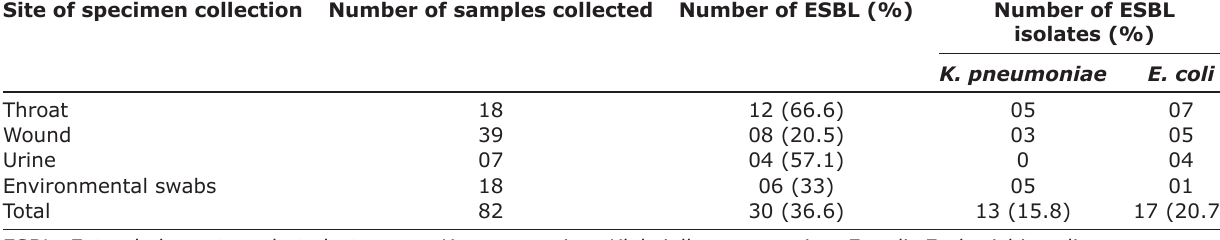
Table-2: Occurrence of ESBL producing